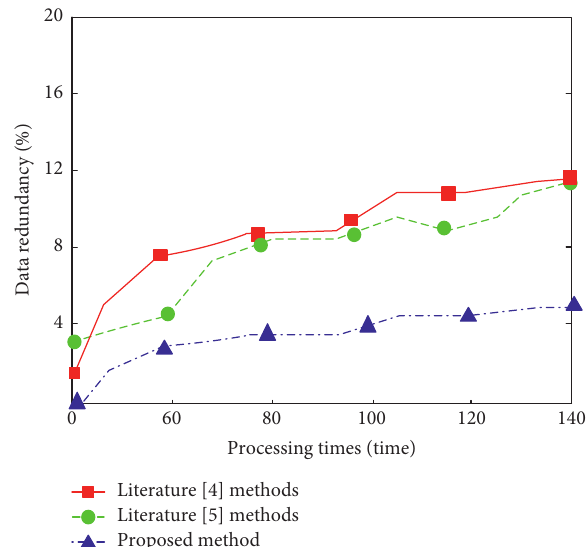
Figure 3: Data redundancy analysis results after integration of different